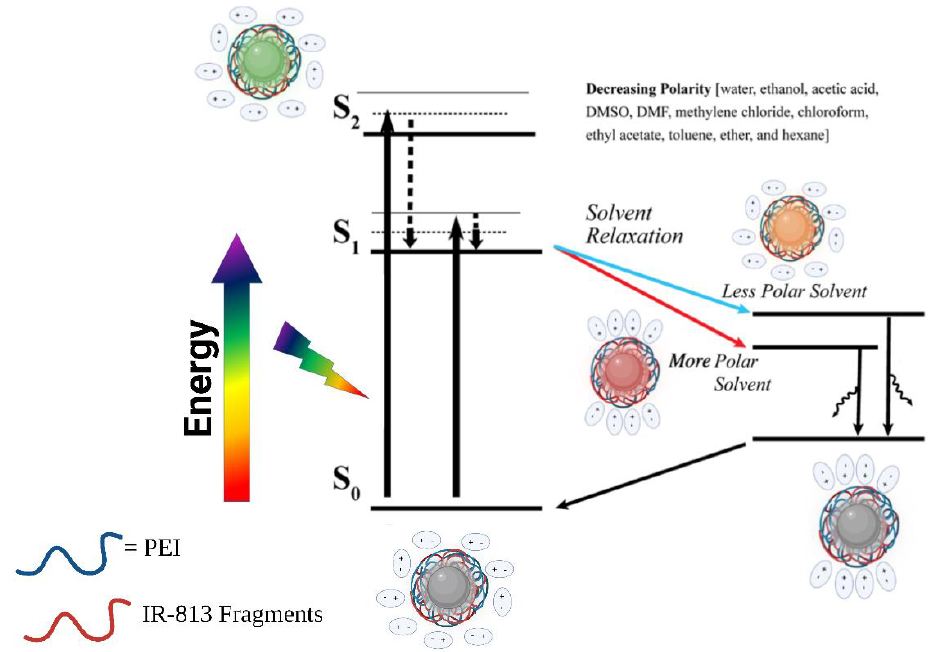
Figure 2. Schematic illustration of the emission mechanism from 813-CDs in solvents of decreasing polarity. Created with BioRender.com , accessed on 1 January 2023.